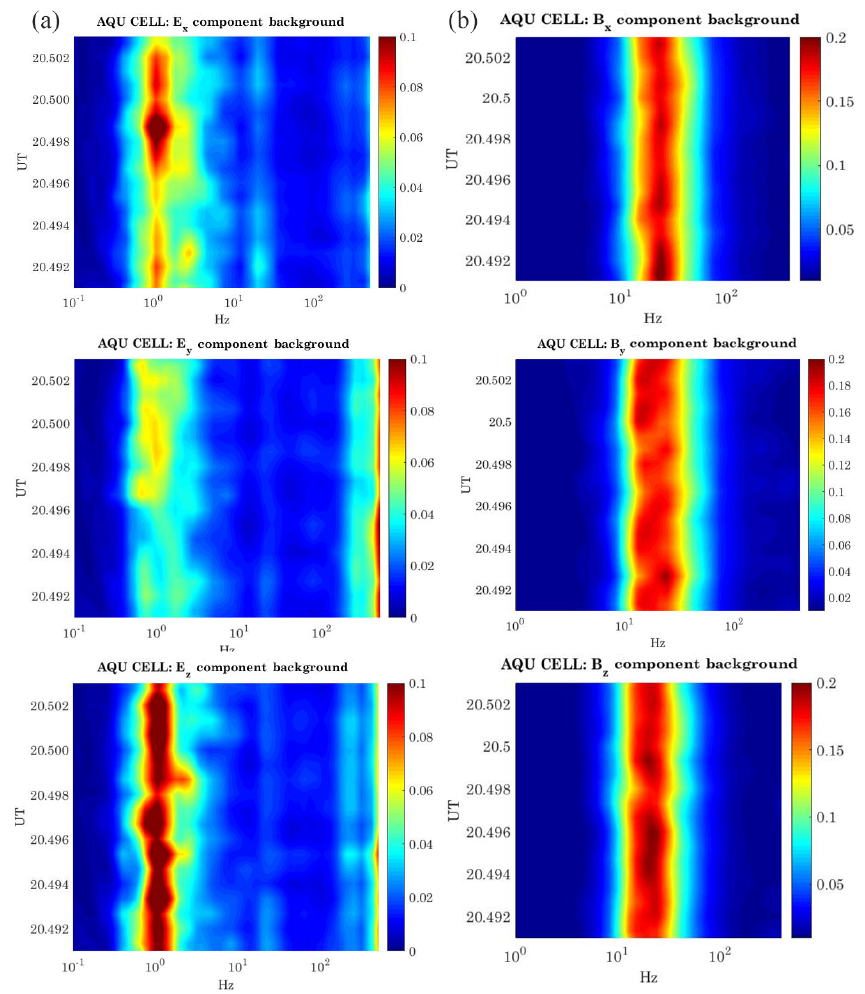
Figure 4. Environmental background for the L’Aquila cell as evaluated by ALIF in terms of (cid:15) rel ((cid:96)) vs. time and frequency for the reference quiet period ( M< 3, Kp < 2, L = night-side). (a) shows the (cid:15) rel ((cid:96)) for the three components of the electric field; (b) shows the (cid:15) rel ((cid:96)) for the three components of the magnetic